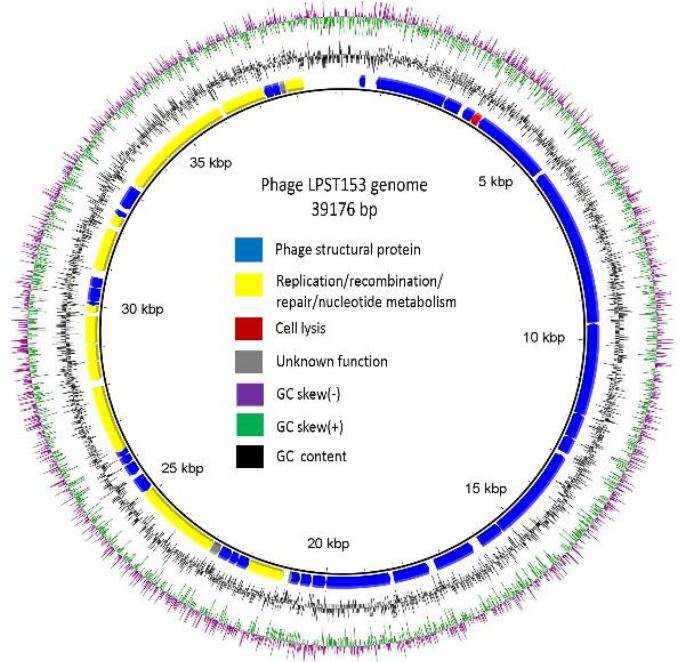
Figure 3. Genome map of phage LPST153. Genome arrangements were divided into four circles: The inner circle indicates the full length of the genome; the second circle indicates the gene coding regions by strand and the clockwise arrow and the counterclockwise arrow denoted the forward reading frame and the reverse reading frame, respectively. The color of each gene refers to the functional category: phage structure (blue), replication/recombination/repair/nucleotide metabolism (yellow), cell lysis (red) and hypothetical proteins (grey). The third circle with a black line indicates the GC content. The outer circle indicates GC skew of G-C/G+C as green and purple: green denotes the values of GC skew were greater than 0 and purple denotes the values were less than 0.